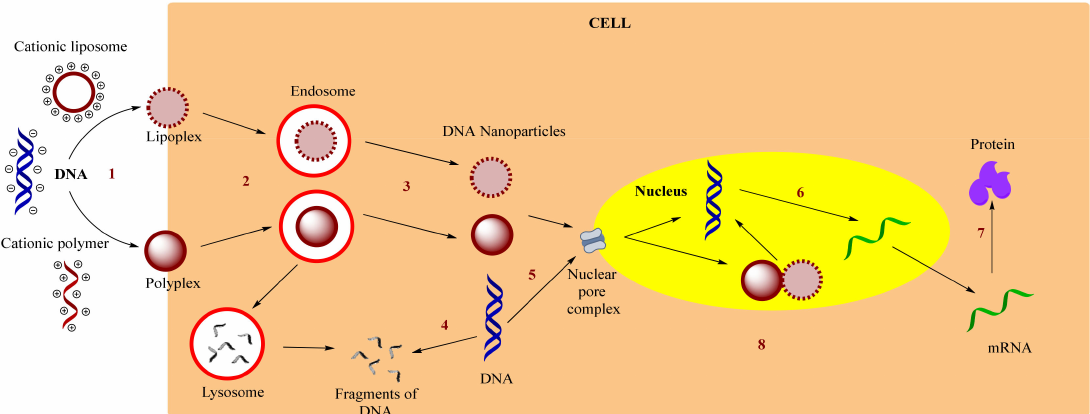
Figure 4. The basic mechanism of nVV gene release through polyplex and lipoplex. (1) condensation; (2) endocytosis; (3) en- dosome escape; (4) degradation of DNA; (5) cytosolic migration; (6) transcription; (7) translation; (8) nuclear translocation. Adapted from [66], published J Transl Med,